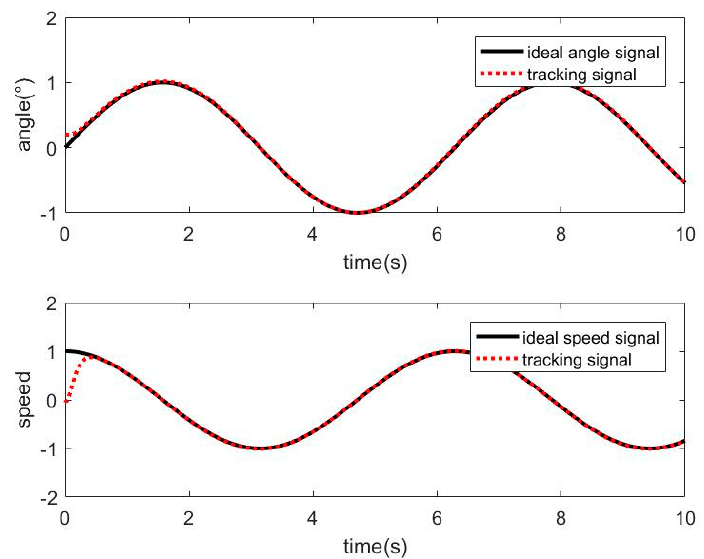
Sensors 2021 , 21 , x FOR PEER REVIEW Figure 6. Tracking curve of SMC with friction disturbance. Figure 6. Tracking curve of SMC with friction disturbance.